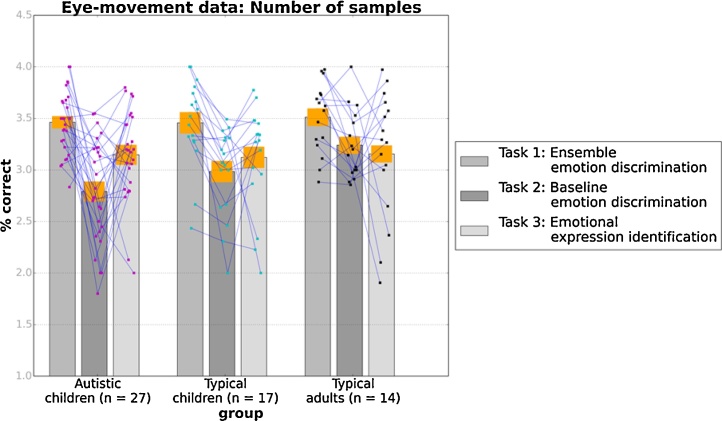
Mean number of different faces scanned by the participants in the three groups across test trials for the three tasks separately. Orange bands correspond to ±1 SEM, while blue lines connect data from the same participant.